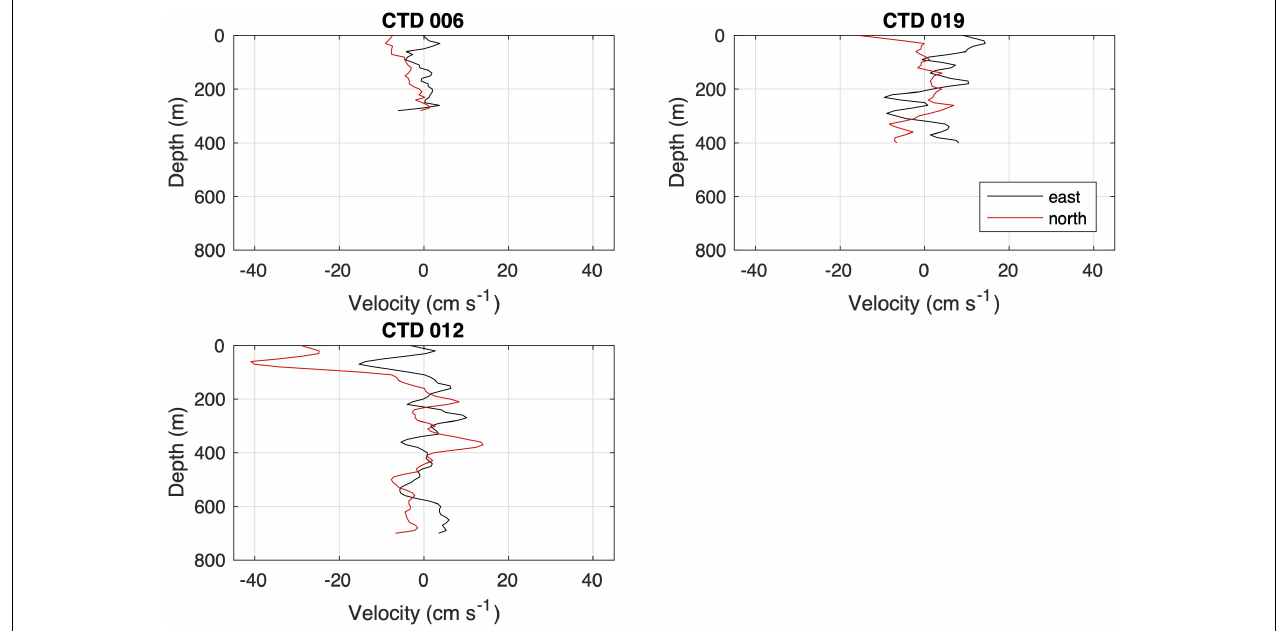
FIGURE 5 | In situ currents from lowered ADCP at Macauley. Black denotes east-west velocity (positive to the east), red is north-south velocity (positive to the north).